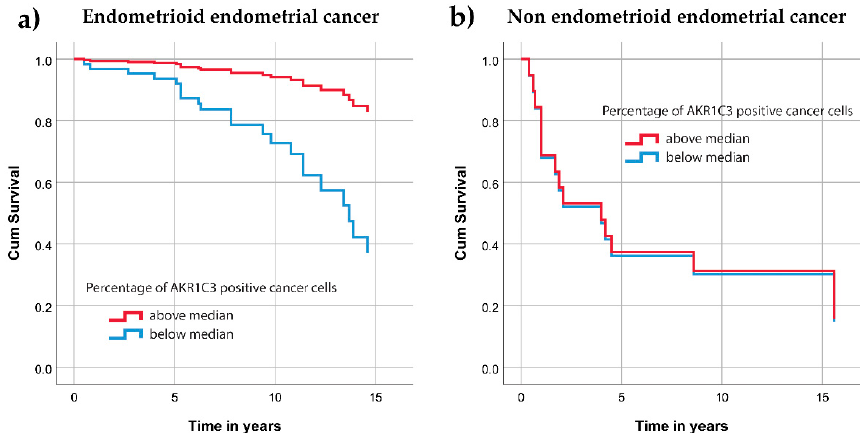
Figure 4. Cumulative survival curves for the AKR1C3 groups separated according to the median values. ( a ) Patients with endometrioid endometrial cancer. ( b ) Patients with nonendometrioid endometrial